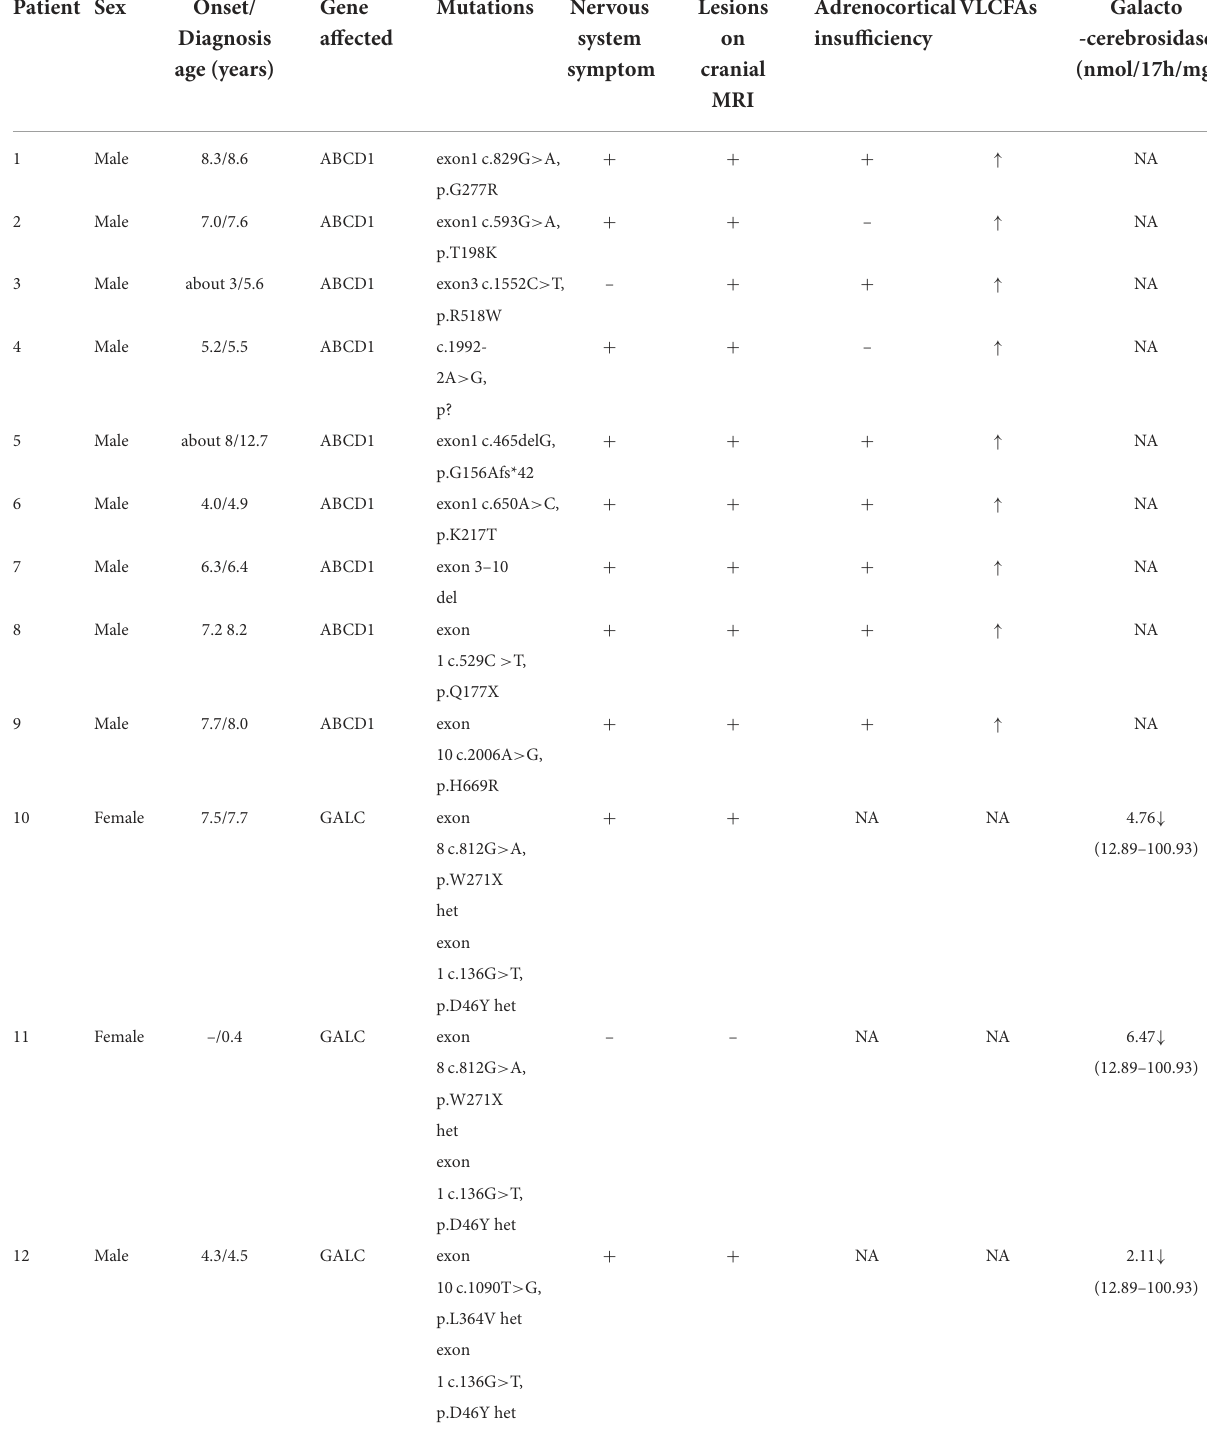
TABLE 1 Baseline clinical characteristics of the 12 patients with heredity leukodystrophy. Patient